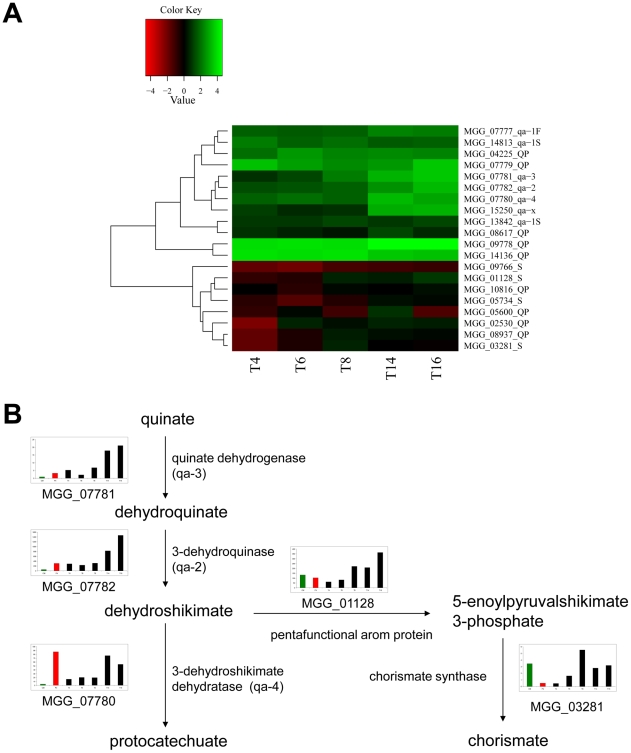
Levels of transcript abundance from genes involved in quinate metabolism.
A. Heatmap showing levels of transcript abundance during time course of appressorium development. Levels of expression are represented as moderated log2 ratio of transcript abundance as compared to mycelium grown in complete medium. Values are from 4 h (T4) to 16 h (T16) after conidia were incubated on a hydrophobic surface. Genes showing similar patterns of gene expression have been clustered. Homologues of genes involved in quinate metabolism in Neurospora crassa are labelled: quinate activator (qa-1F), quinate repressor (qa-1S), 3-dehydroquinase (qa-2), Quinate dehydrogenase (qa-3), 3-dehydroshikimate dehydratase (qa-4), function unknown (qa-x), quinate permeases (QP), shikimate pathway (S). B. Expression of genes involved in quinate metabolism. For each enzyme, bar graphs show abundance of transcripts encoding the gene in: Guy11 mycelium grown in complete medium (green bar), Δpmk1 mutant conidia left to germinate for 4 h (red bar), a Guy11 time course of appressorium development (4 h, 6 h, 8 h, 14 h, 16 h – black bars left to right).